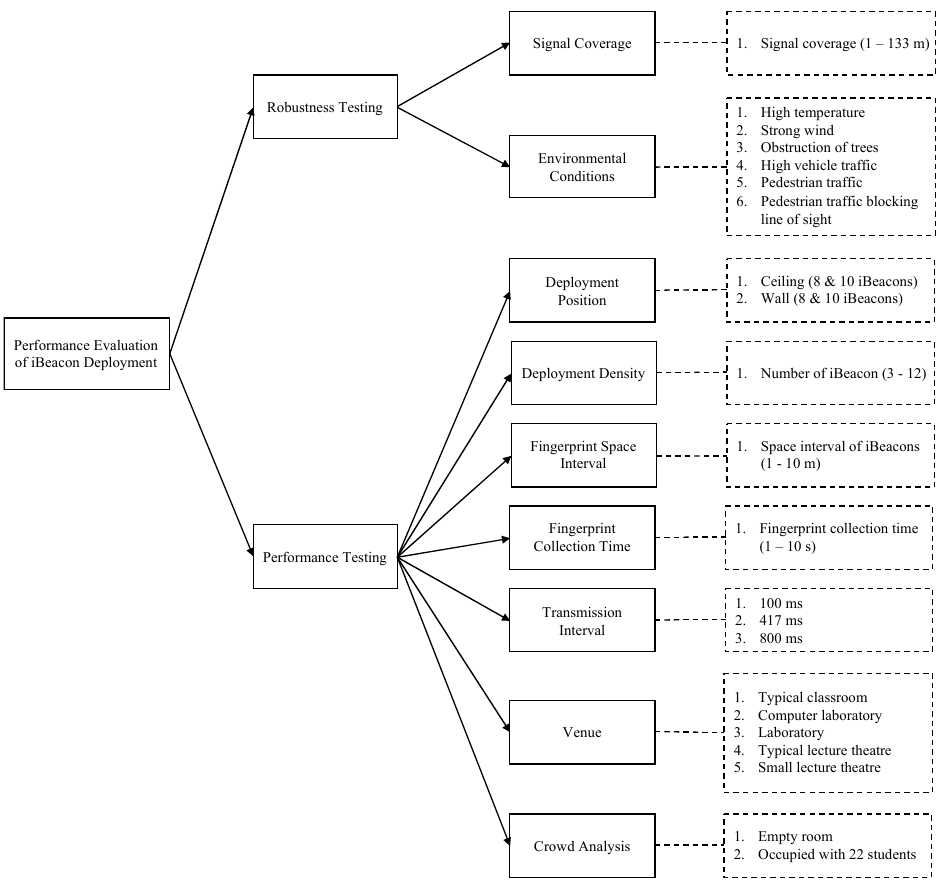
Figure 1 . Overall framework of the study. Figure 1. Overall framework of the